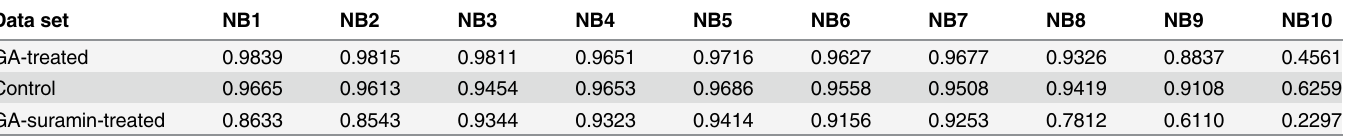
Table 4. R 2 values indicating the goodness of fit between the model and the data. Data set